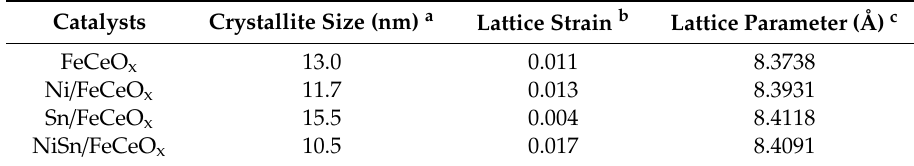
Table1. Size, lattice strain, and lattice parameter of FeCeO x , Ni / FeCeO x , Sn / FeCeO x , andNiSn / FeCeO x Table 1. Size, lattice strain, and lattice parameter of FeCeO x , Ni/FeCeO x , Sn/FeCeO x , and NiSn/FeCeO x catalysts.